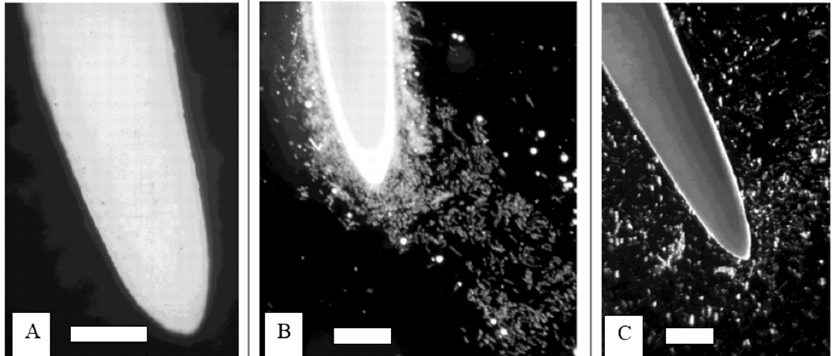
Figure 1. Dynamics of border cell dispersal upon immersion into water. ( A ) When roots are maintained at >98% humidity, border cells remain tightly appressed to the surface and invisible; ( B ) Upon immersion of the root tip into water, the root cap mucilage absorbs water instantaneously, and cells begin to disperse within seconds; ( C ) Within minutes, all border cells disperse into suspension, leaving the root tip surface free of cells. Scale bars: 1 mm.